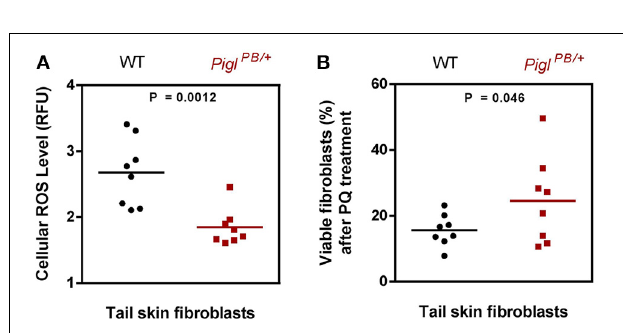
FIGURE 6 | Characterization of Pigl PB / + fibroblasts. (A) ROS level. Tail skin fibroblasts isolated from wild-type (WT) and Pigl PB / + mice were stained with CM-H 2 DCFDA and the fluorescence was normalized against Hoechst. The ROS content was expressed as relative fluorescence unit (RFU). The P value was evaluated by two tailed Student’s t -test ( n = 8). (B) PQ resistance. Tail skin fibroblasts from wild-type (WT) and Pigl PB / + mice were exposed to 4mM PQ for 6h, after which the viability of the cells were measured by MTT assays. The percentage of live cells after PQ treatment was calculated by the ratio of the absorbance obtained from the PQ-treated cells and that from the un-treated cells. The P value was evaluated by one tailed Student’s t -test ( n = 8). Each dot or square represent one individual